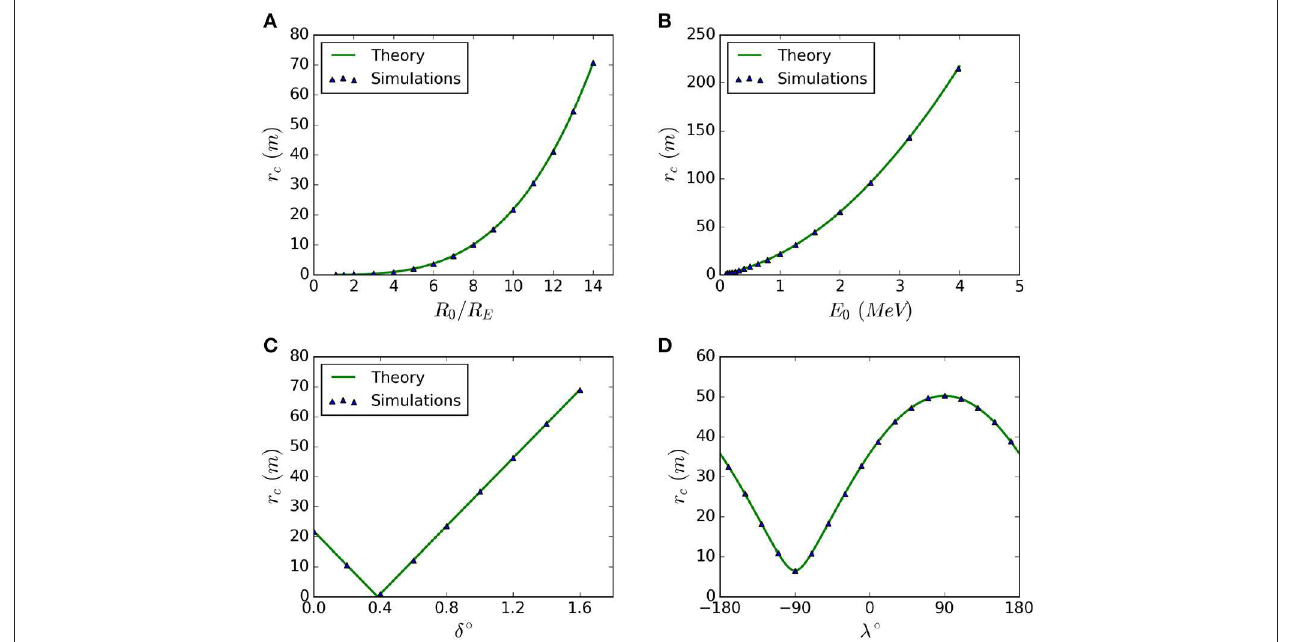
0 ◦ , injection from 10 R E ˆ X and reference beam properties of = − 90 ◦ , (D) with azimuthal injection = −